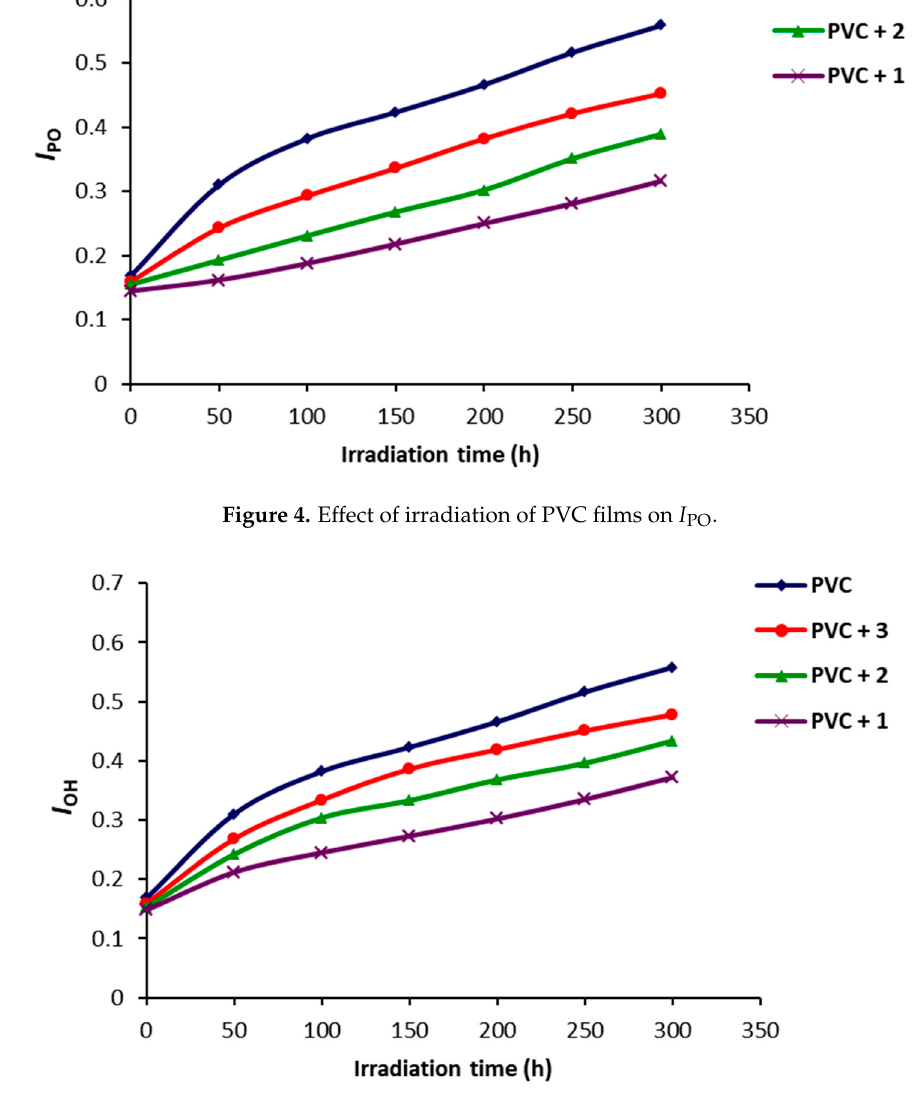
Figure 5. Effect of irradiation of PVC films on I OH .